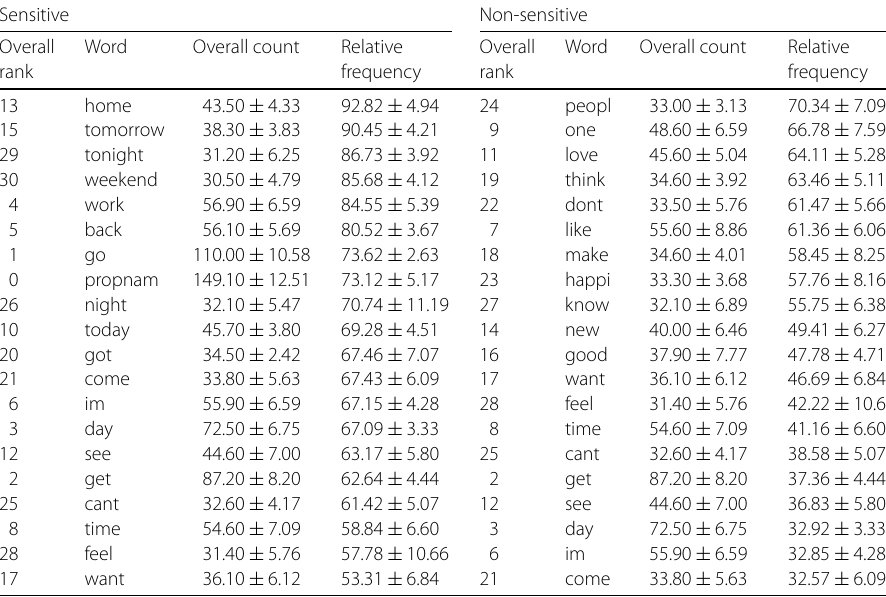
Table 6 Most relevant words for each class in dataset